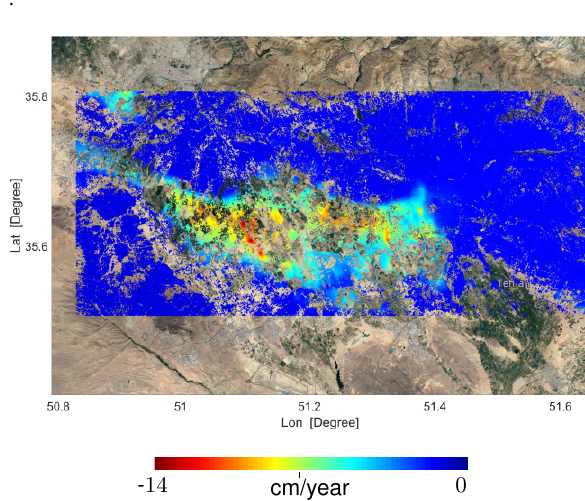
Figure 4. Tehran basin subsidence with conventional SM method in ascending orbit.